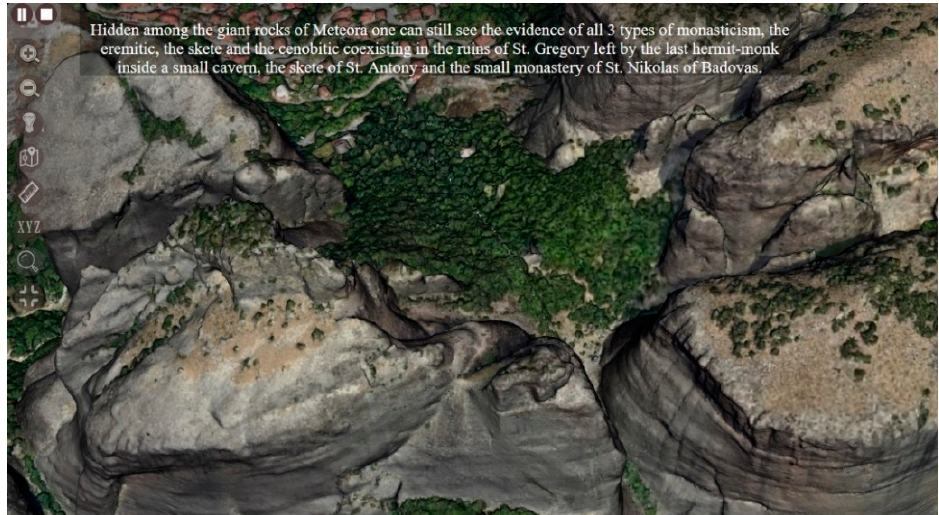
Figure 11. Snapshot during the automatic navigation while camera frames pillars with remains of sketes.